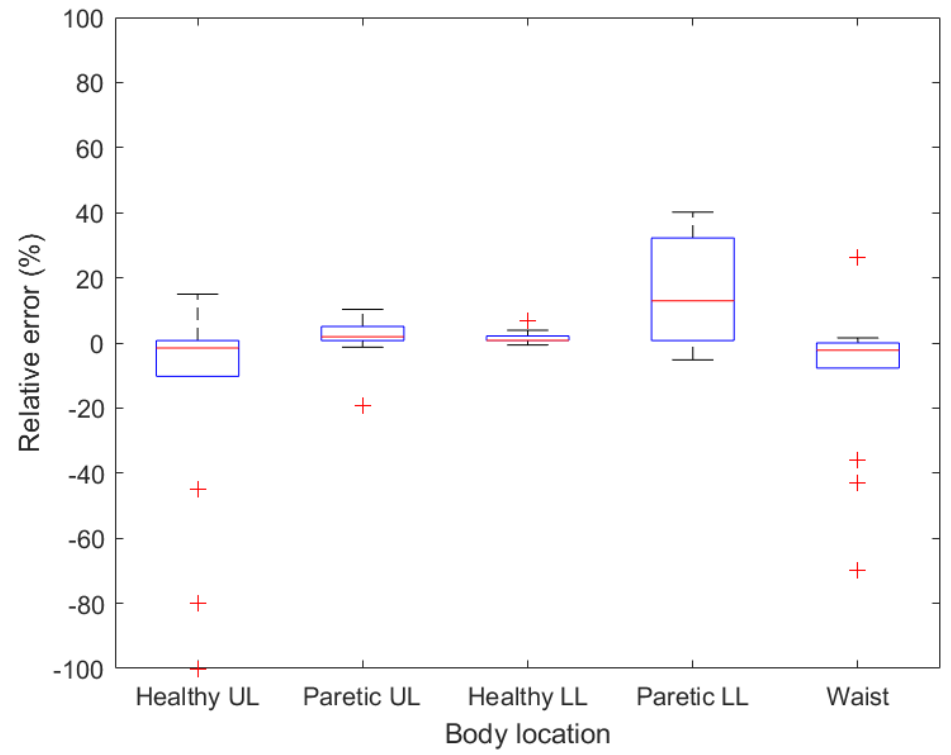
Figure 4. Boxplots demonstrating relative error for given body location when no walking aid is used. UL—upper limb, LL—lower limb.